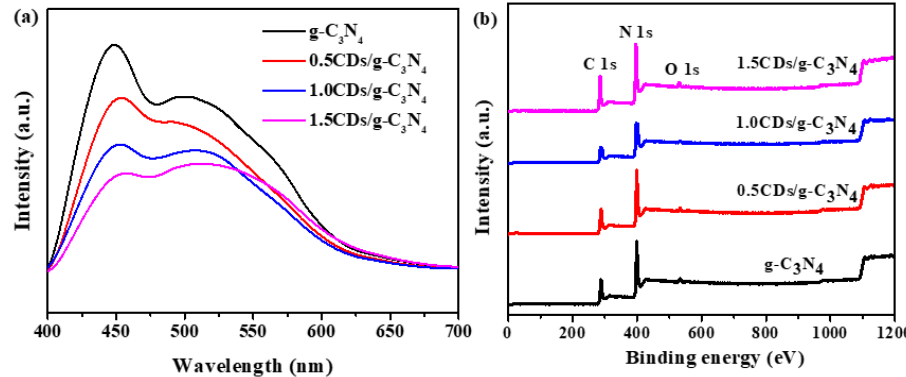
Figure 6. The ( a ) PL spectrum and ( b ) XPS survey spectrum of CDs/g ‐ C 3 N 4